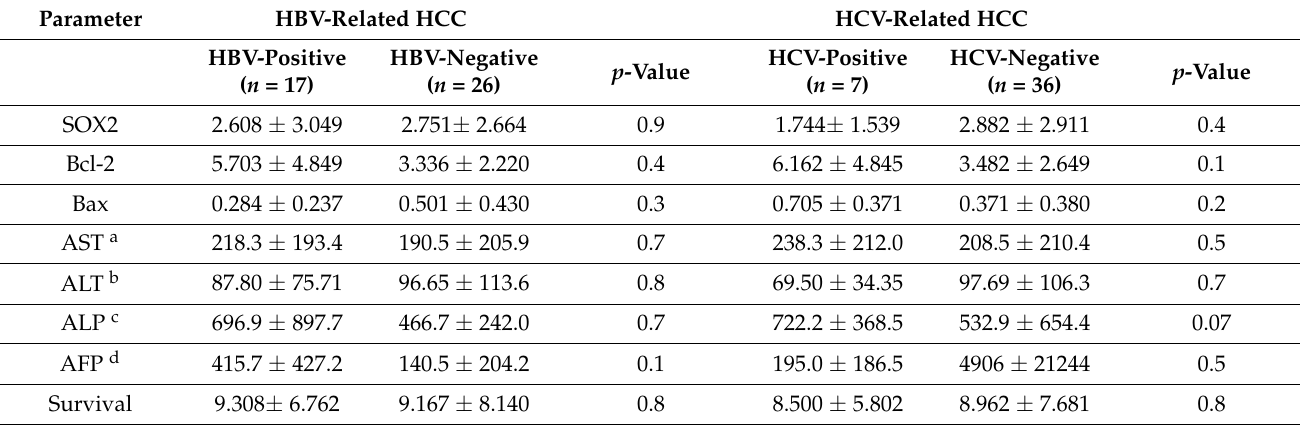
Table 4. Effect of HBV-, HCV-related HCC on gene expression and liver function activity. Parameter